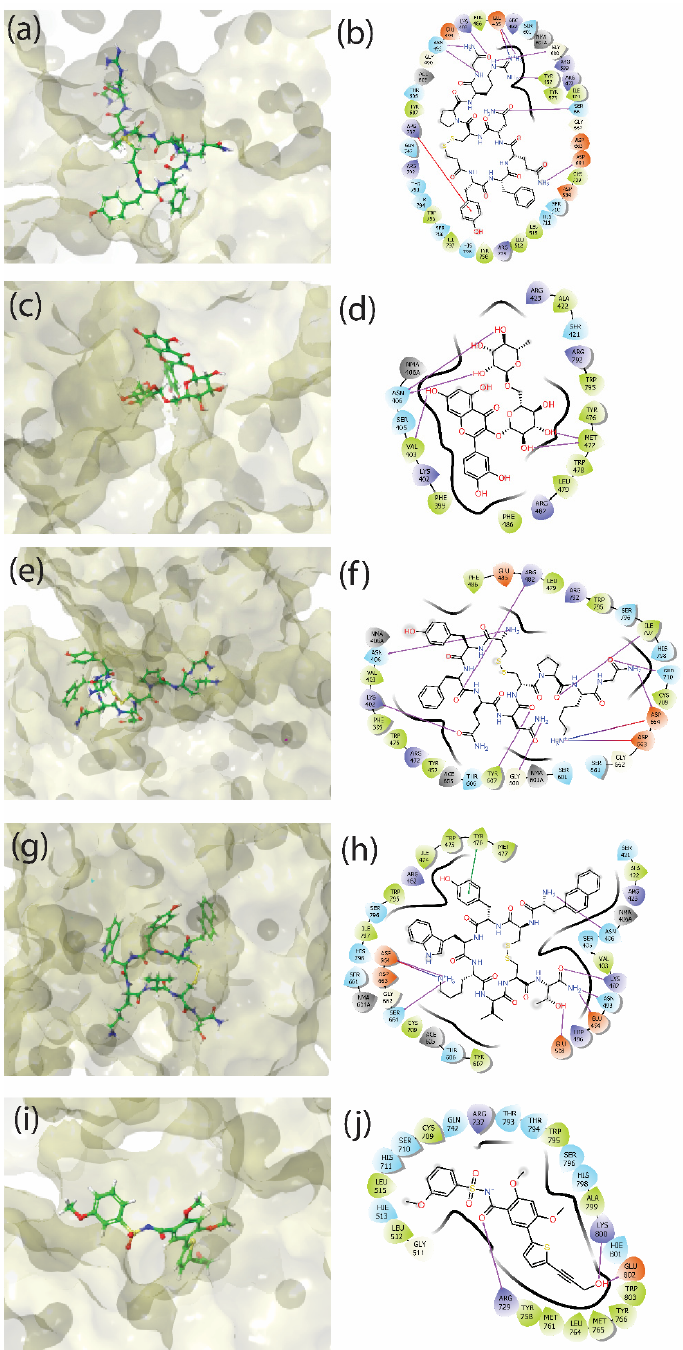
Figure 4. The 3D and 2D binding interaction plots for the best poses of the four selected drug com- pounds screened—( a , b ) desmopressin, ( c , d ) rutin ( e , f ), lypressin, and ( g , h ) lanreotide—and ( i , j ) the native ligand